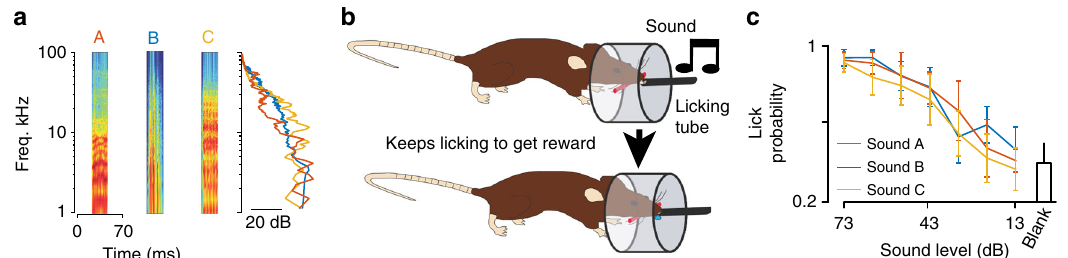
Fig. 1 Spectro-temporal differences in complex sounds do not affect near-threshold detectability. a Spectrograms of three 70-ms-long complex sounds, with power spectrum on the right. b Schematics describing the auditory detection task. c Mean response probability for six mice trained to detect sounds A, B, and C at 73 dB to get a reward and probed with lower sound intensities. While the effect of intensity was signi fi cant, there was no effect of sound identity (Friedman test, p intensity = 2.3 × 10 − 9 , p sound = 0.43, n = 6 mice). Error bars represent standard errors (SEM). Source data are provided as a